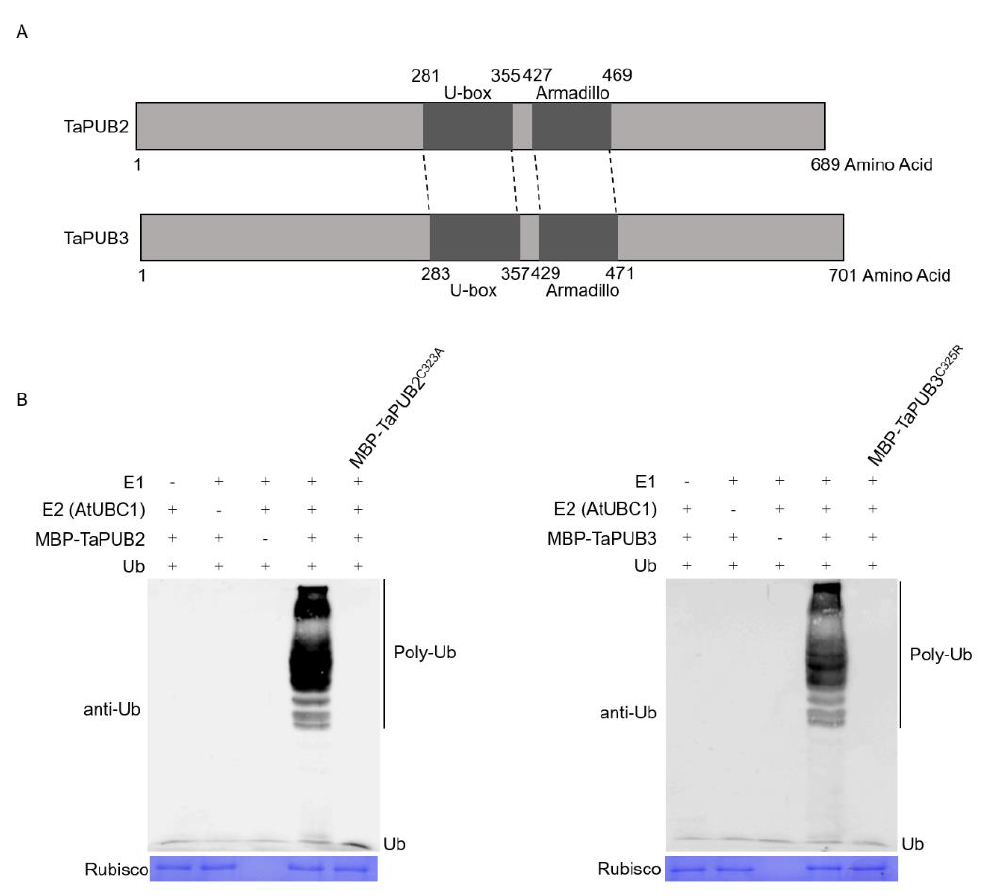
Figure 4. In vitro E3 ligase activity of TaPUB2 and TaPUB3. ( A ) Schematic diagram of full-length TaPUB2 and TaPUB3 proteins. The solid bar depicts the protein length. The U-box and Armadillo repeat domain are shown as dark gray bars. ( B ) The ubiquitination reaction contains E1 (human), E2 (AtUBC1), E3 (MBP-TaPUB2, MBP-TaPUB2 C323A , MBP-TaPUB3, and MBP-TaPUB3 C325R ), and ubiquitin. Polyubiquitin chains are visible by immunoblotting with a ubiquitin antibody. (+) means presence, and (-) means absence.